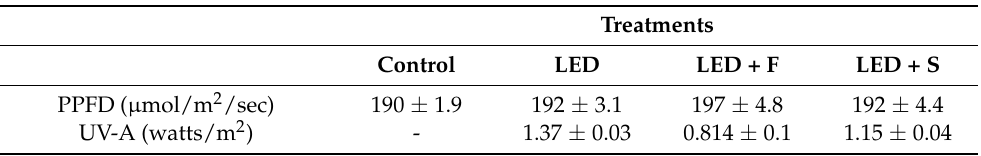
Table 1. Average PAR and UV-A levels (with S.E, n = 9) under LEDs, LEDs + focus lens (LED + F), LEDs + scatter lens (LED + S), and control. Treatments Control LED